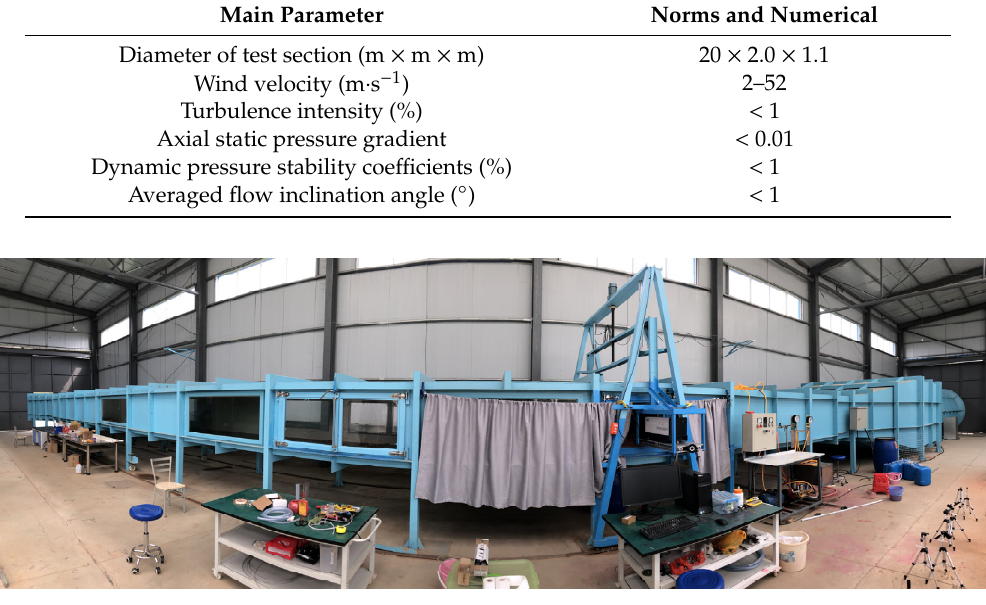
Figure 1. SCAU wind